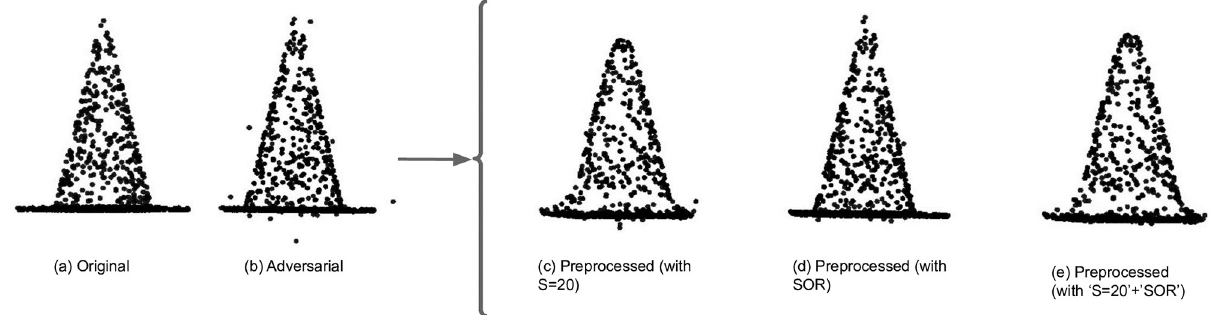
Fig 6. Visualization of different preprocessed on an adversarial point cloud sample. (a) Illustrate original point cloud and others illustrate adversarial point clouds when (b) generated with Add-CH attack, (c) Preprocessed with S = 20, (d) preprocessed with SOR, and (e) Preprocessed with both SOR and S = 20. Point cloud in (e) has the least outlier, as